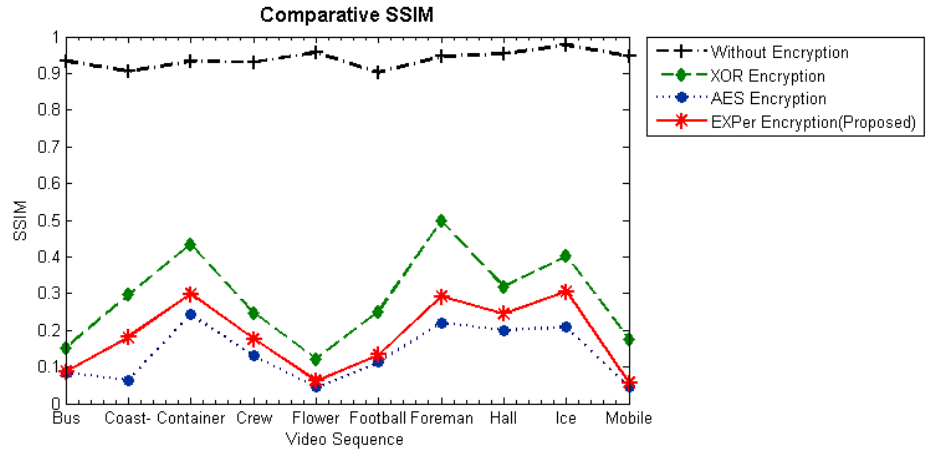
Figure 10. Comparison between SSIM values for XOR, AES-CFB and EXPer for selective encryption with combined motion and texture parameters at QP = 36 on 10 tested video sequences.